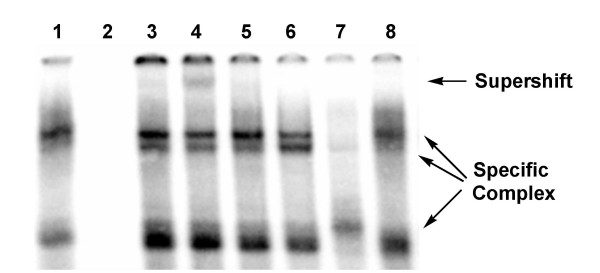
EMSA with 32P-labeled C/EBP oligonucleotide (-117 to -109) and JEG-3 cell extracts (CE). Lane 1: labeled oligonucleotide+CE; lane 2: labeled oligonucleotide-CE; lane 3: labeled oligonucleotide+CE+C/EBP-α IgG; lane 4: labeled oligonucleotide+CE+C/EBP-β IgG; lane 5: labeled oligonucleotide+CE+C/EBP-δ IgG; lane 6: labeled oligonucleotide+CE+non-immune rabbit IgG; lanes 7–8: labeled oligonucleotide+CE+250-fold molar excess of unlabeled wild type (lane 7) and mutated (lane 8) C/EBP competitor oligonucleotides.